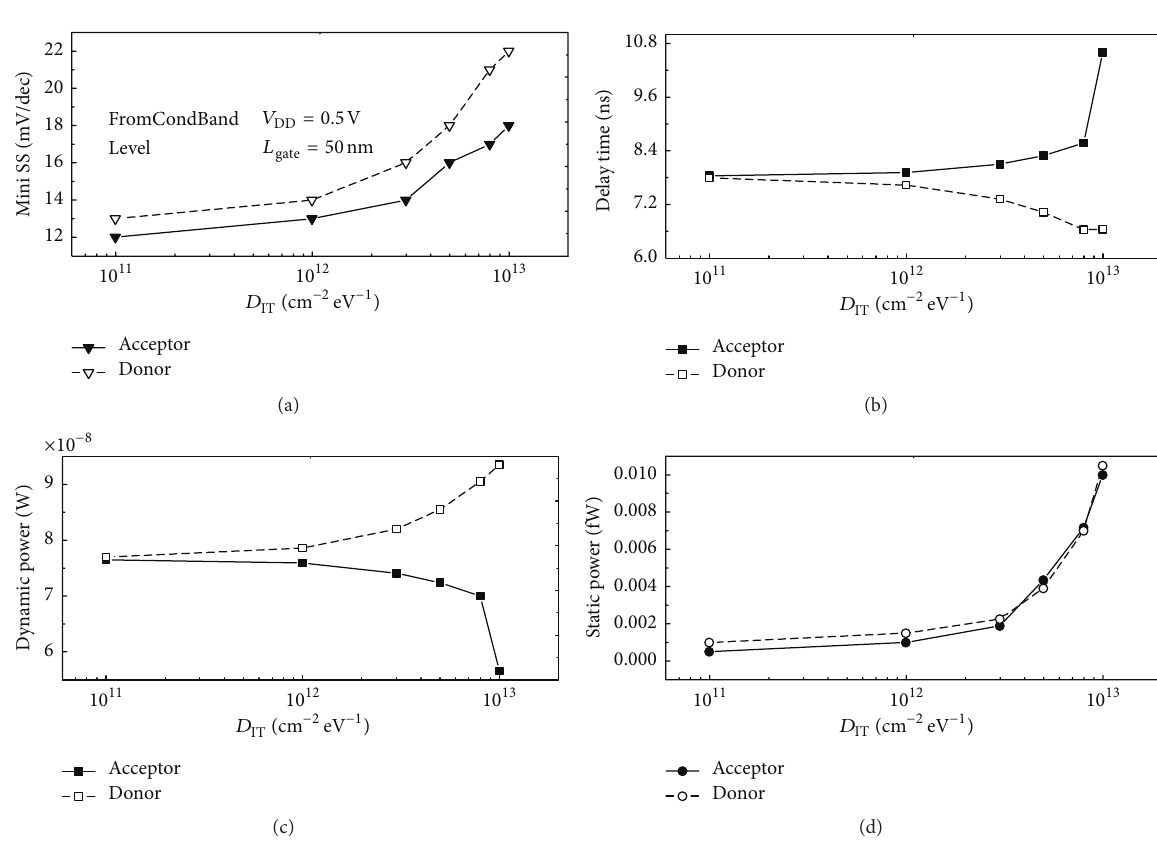
10(d), 12(a), 12(d), 14(a), and 14(d). The static power and mini SS would be increased no matter where the ITs level